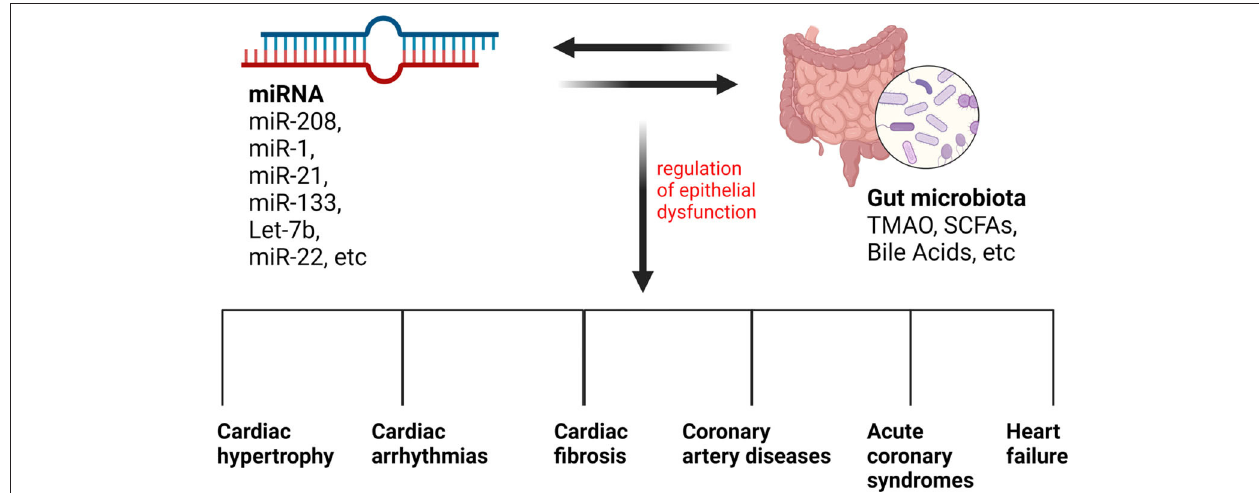
FIGURE 4 | The relationship between gut microbiota, miRNAs, and CVDs. Different types of miRNAs and gut microbiota metabolites can influence each other, influencing the regulation of epithelial dysfunction and leading to many CVDs.